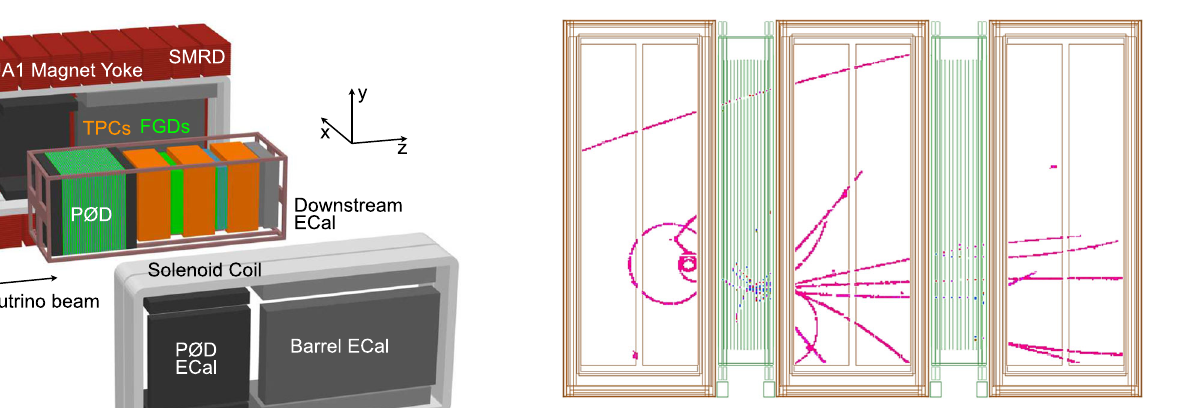
T2K physics data-taking started in January 2010 and contin- ues in 2020 and beyond. The data-taking history is shown in Fig. 52. A maximum beam power of 500 kW was